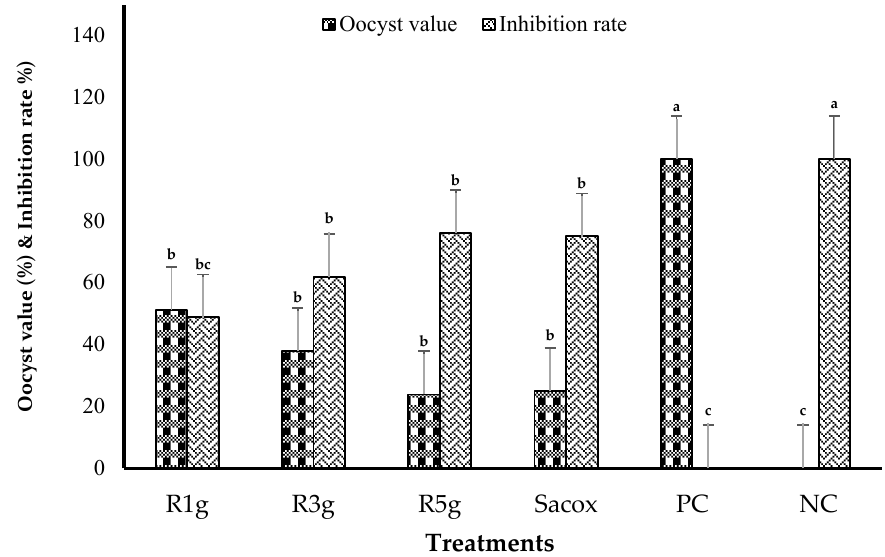
Figure 2. Effect of experimental treatments and challenge with E. tenella on oocyst value and inhibition rate at 7 d postinoculation; R1g, R3g, and R5g are 1, 3, and 5 g RN/kg diet, respectively, Sacox: 66 mg of salinomycin/kg diet; PC and NC: basal diet with and without coccidiosis challenge, respectively. Different lowercase letters indicate significant differences.